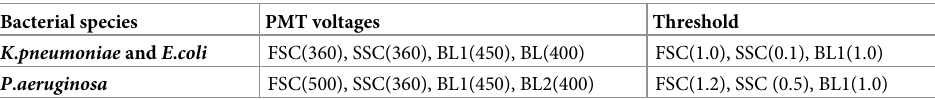
Table 1. NxT AFC